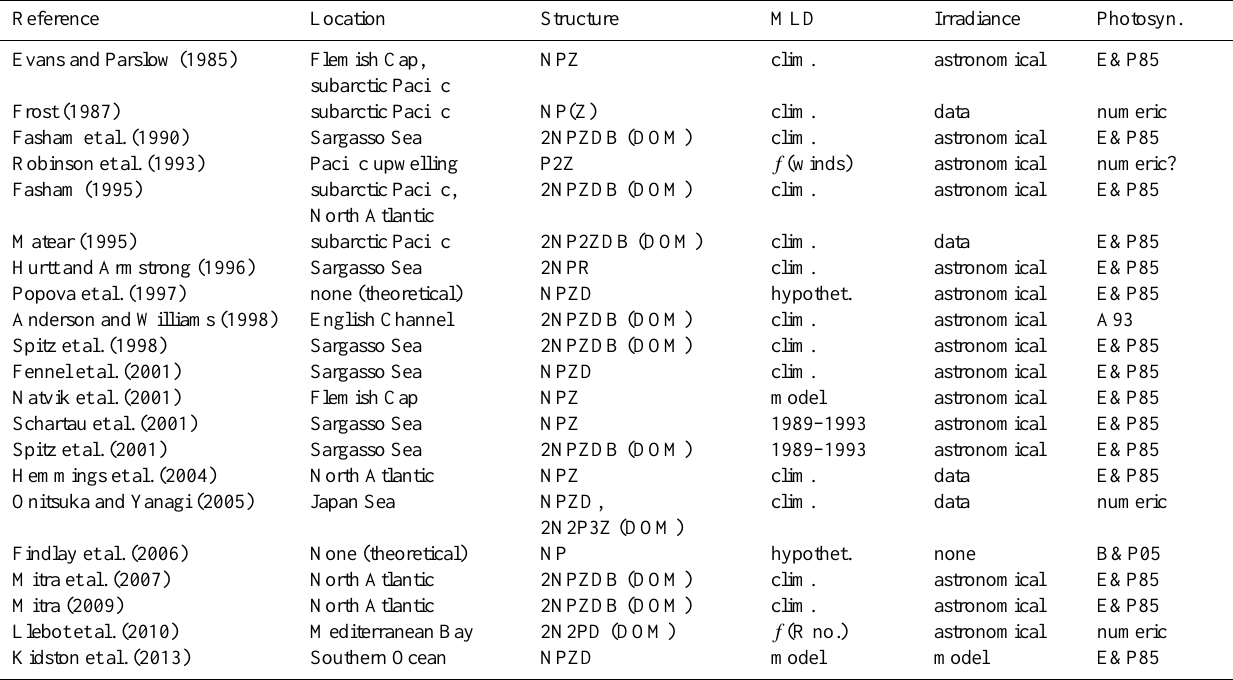
Table 1. Characteristics of published slab